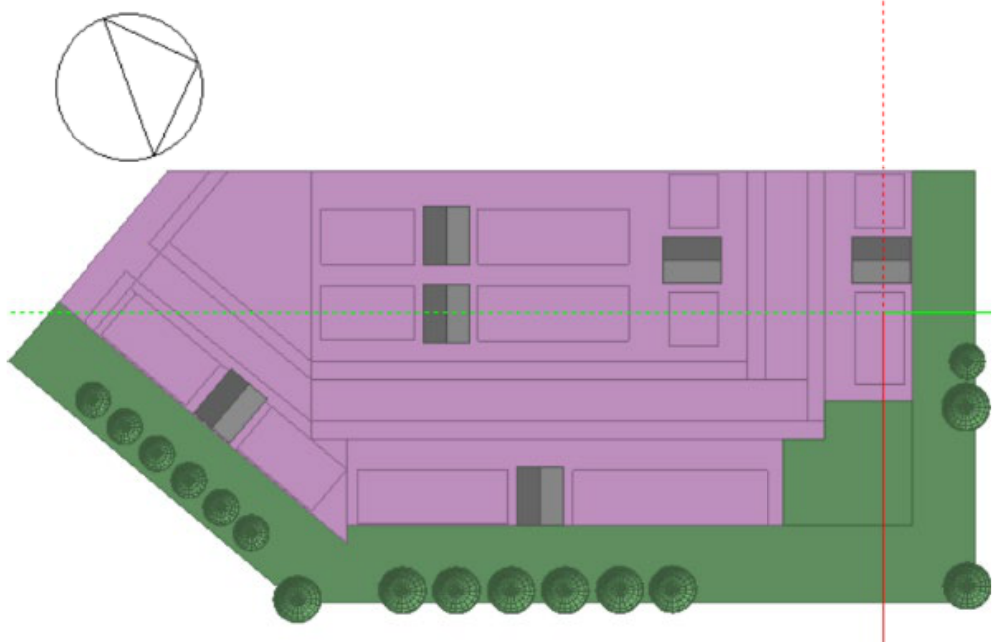
Figure 8. Plan view of the simplified model created in DesignBuilder for the sensitivity and optimi- zation analyses.